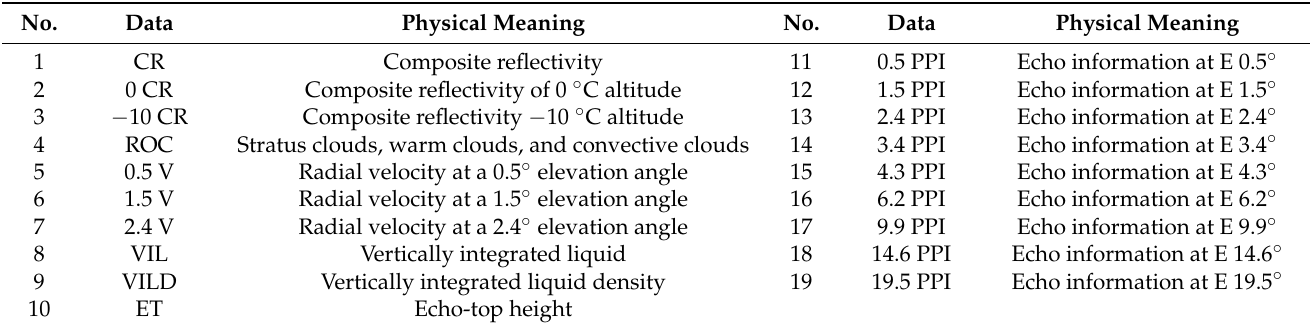
Figure 1. Locations of the weather radar and ADTD lightning positioning system stations in Ningbo. The red star denotes the radar station, the purple crosses represent the lightning observation stations, and the blue box indicates the experimental area with color representing the topography. Table 1. Radar products used for cloud-to-ground (CG) lightning